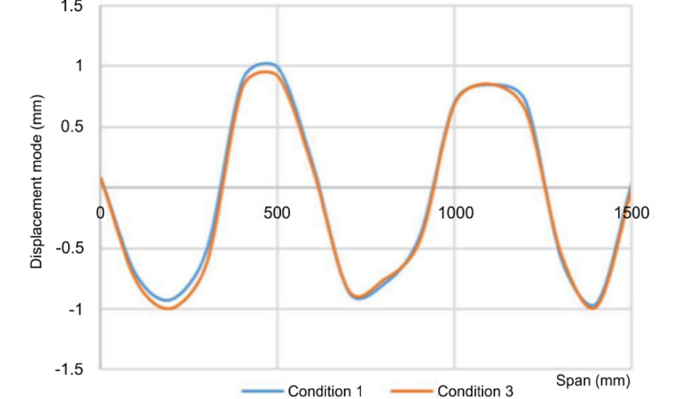
Figure 10. Comparison of the first five orders of vibration modes under Conditions 1 and 3. The comparison results of displacement modes at different orders under Condition 1 (single-span nondamaged) and Condition 4 (single-span double-damage) are shown in Figure 11.